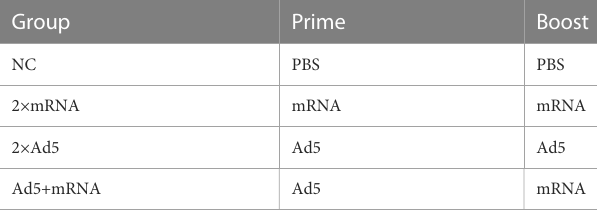
TABLE 1 Schedule for different immunization regimens. Group